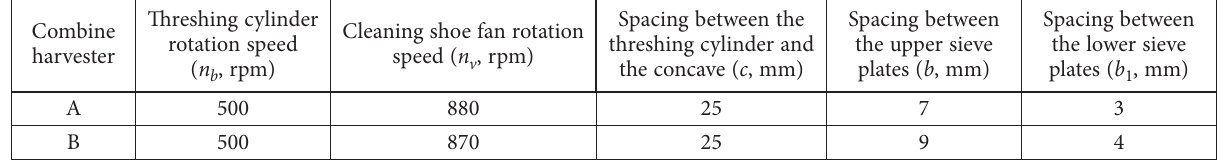
Table 2. Technological parameters of combine harvesters